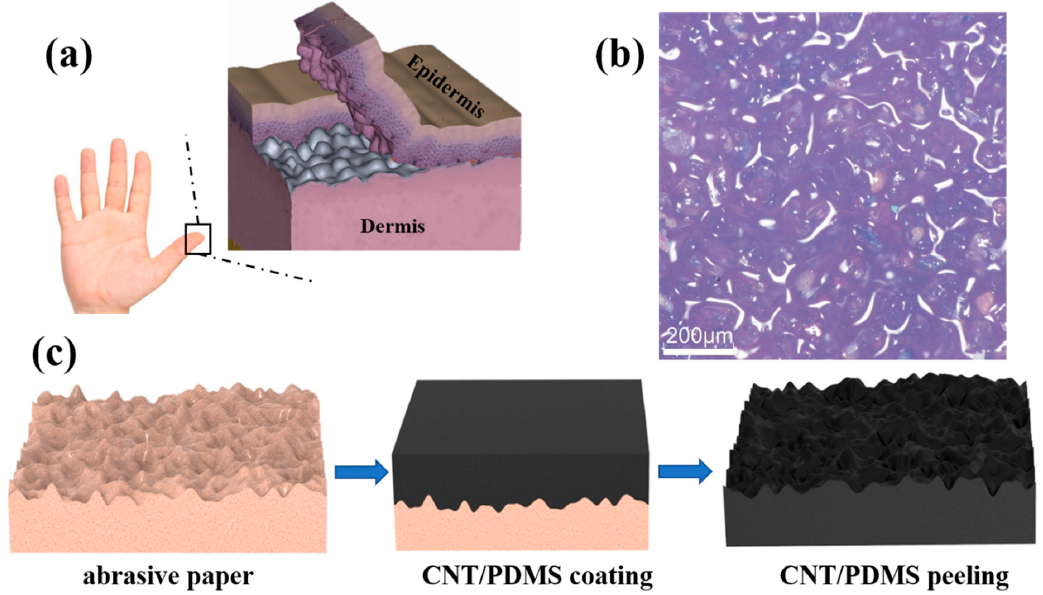
Figure 1. ( a ) Schematics of the microstructure of human epidermis. ( b ) Optical microscopy image of the no. 400 abrasive paper. ( c ) The fabrication process of the spinosum microstructure pressure